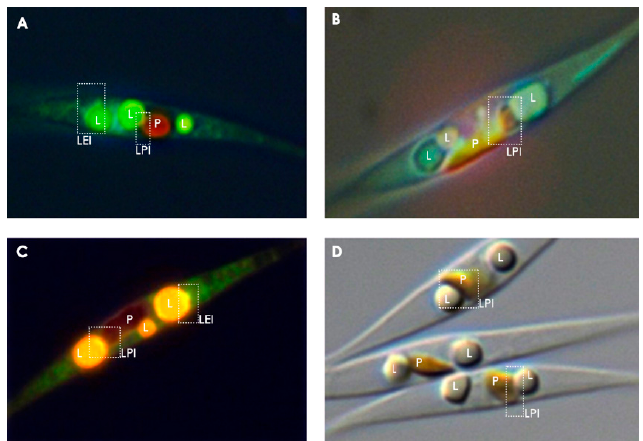
Figure 2. Micrographs of nitrogen starved P. tricornutum cells, illustrating potential interconnectivity between LDs and various cellular compartments. Plastidial autofluorescence appears red, the LD stain Nile Red fluoresces yellow and the ER/mitochondrial/endomembrane stain DiOC 6 fluoresces green/greenish blue. ( A ) Epifluorescent image of cells stained with Nile Red and DiOC 6 , ( B ) Epifluorescent image of cells stained with only DiOC 6 , ( C ) Epifluorescent image of cells stained with Nile Red and DiOC 6 , ( D ) Differential interference contrast image with no epifluorescent staining. P = plastid, L = lipid droplet, LPI = lipid droplet-plastid interface, LEI = lipid droplet-endomembrane interface. The interfacial regions, emphasized in boxes with dotted lines, are speculated to be potential regions of interaction between LDs and other organelles.